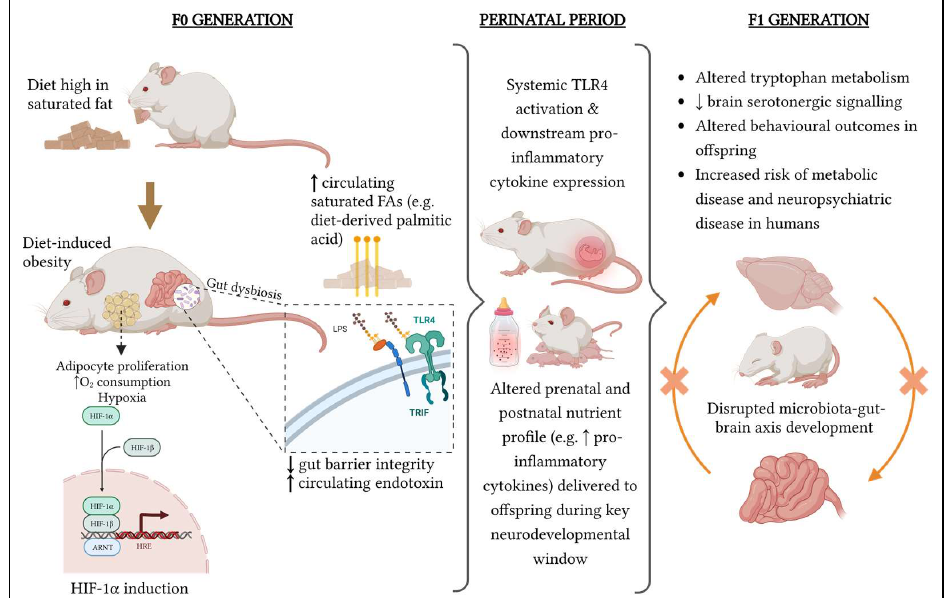
Figure 2. Mechanistic overview of the convergent mechanisms by which maternal-diet-induced obesity and microbiome dysbiosis induce toll-like receptor 4 (TLR4) activation, increasing maternal inflammation during the perinatal period and disrupting the development of the gut–brain axis in the offspring.